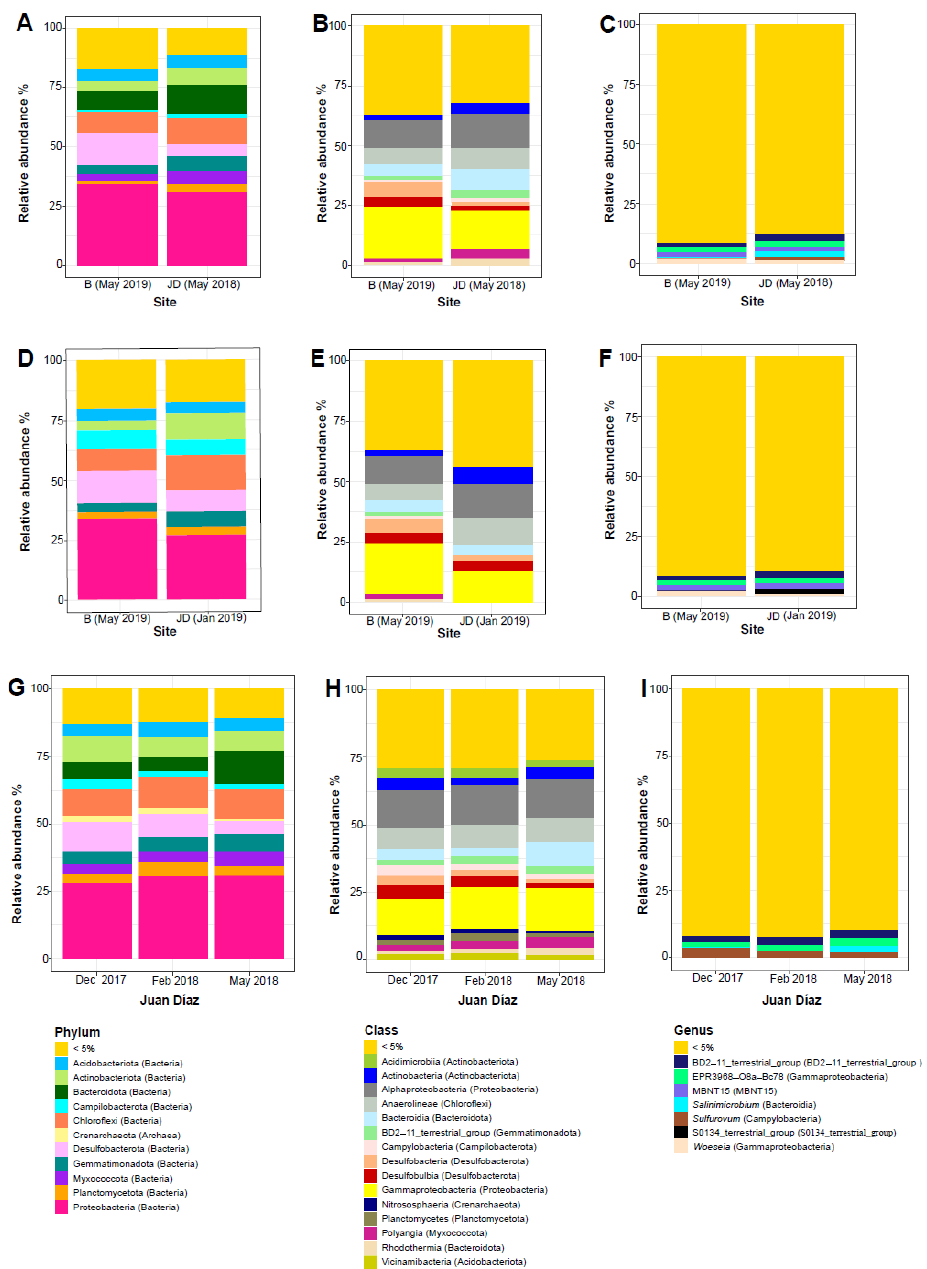
Figure 5. Relative abundance of the most common bacterial taxa in the two mangrove sites, Bayano (B) and Juan Diaz (JD), in different time points and seasons. Comparison of Bayano and JD in a rainy season month of different years ( A – C ); Bayano in a rainy season month compared to JD in a dry season month ( D – F ); and different time points in JD in the transition from rainy (Dec 2017) to dry (Feb 2018) to rainy (May 2018) season. Abundance was estimated at the ranks of phylum ( A , D , G ), class ( B , E , H ), and genus ( C , F , I ).